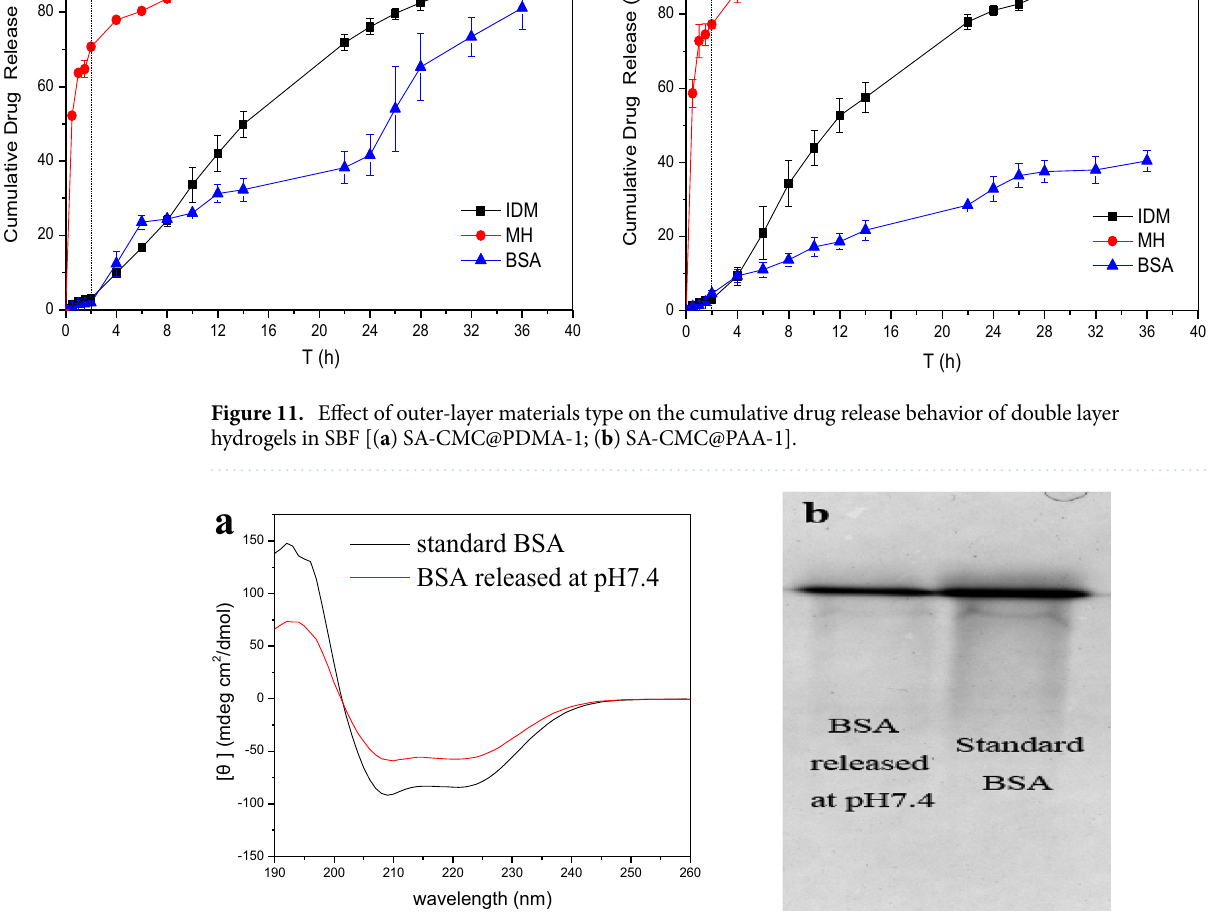
Figure 12. Stability determination of the released BSA [( a ) CD spectra of standard BSA and BSA released from the SA-CMC@PDMA-3 in SIF; ( b ) SDS-PAGE gel of the BSA released from the SA-CMC@PDMA-3 in SIF and BSA